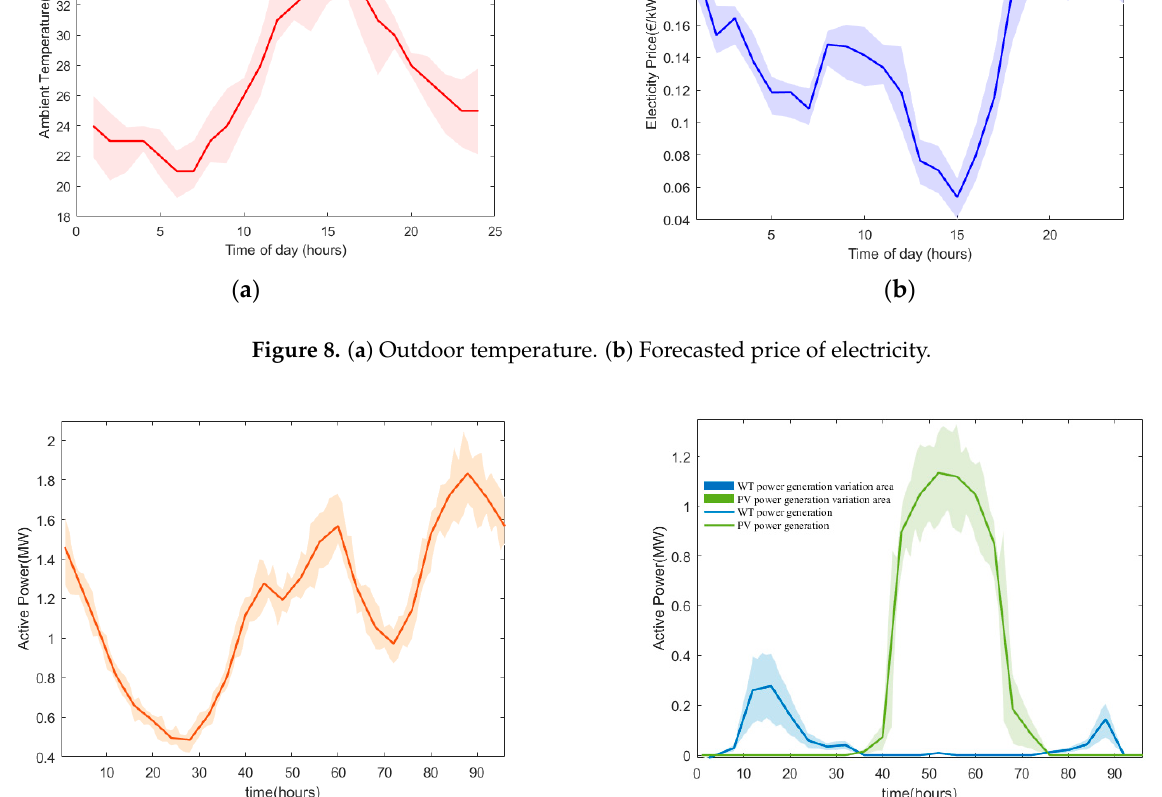
Figure 9. ( a ) ADN load consumption. ( b ) WT and PV power production and their variation areas.